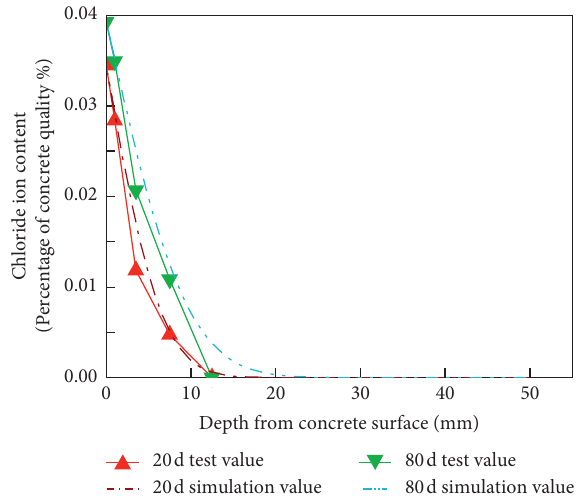
Figure 10: Chloride content distribution in concrete at 20d